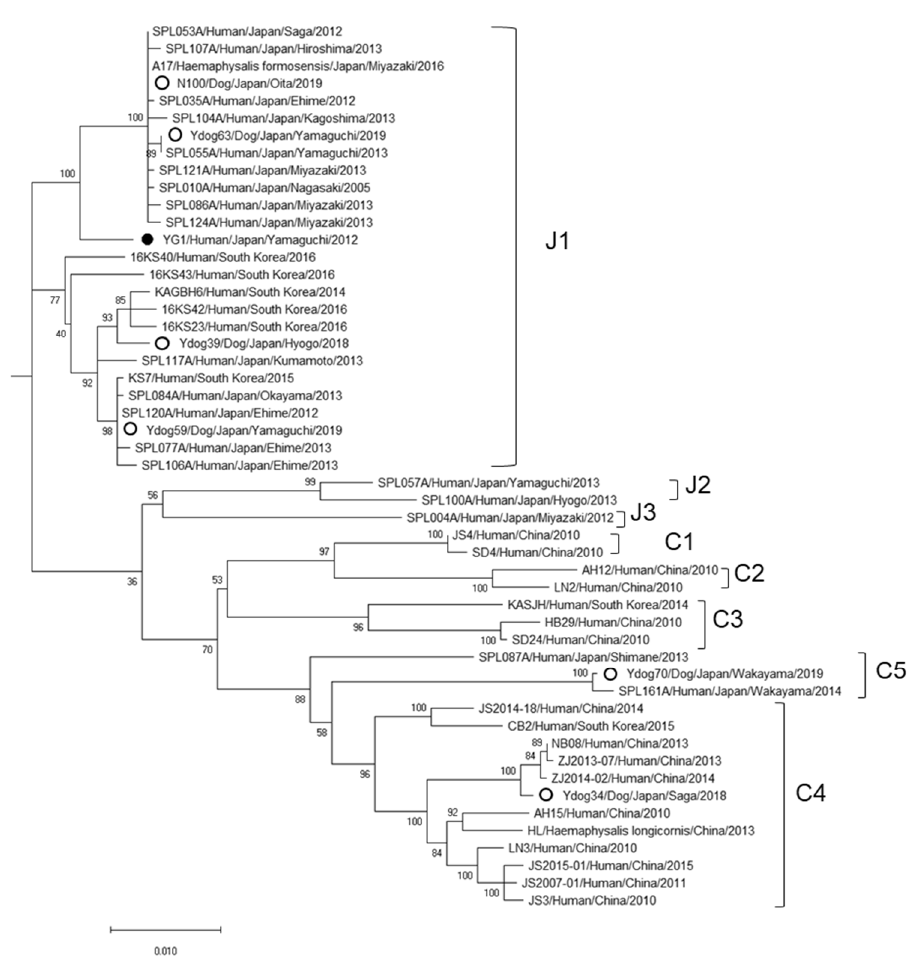
Figure 3. Phylogenetic analysis by the maximum likelihood method based on the nucleotide sequences of small (S) segments (1697 bp). The Guertu virus used as an outgroup is not shown. The open circles indicate the virus strain isolated from a dog in this study. The closed circle indicates the virus strain isolated from the first human patient in Japan. The genotype is shown to the right of the strain name.